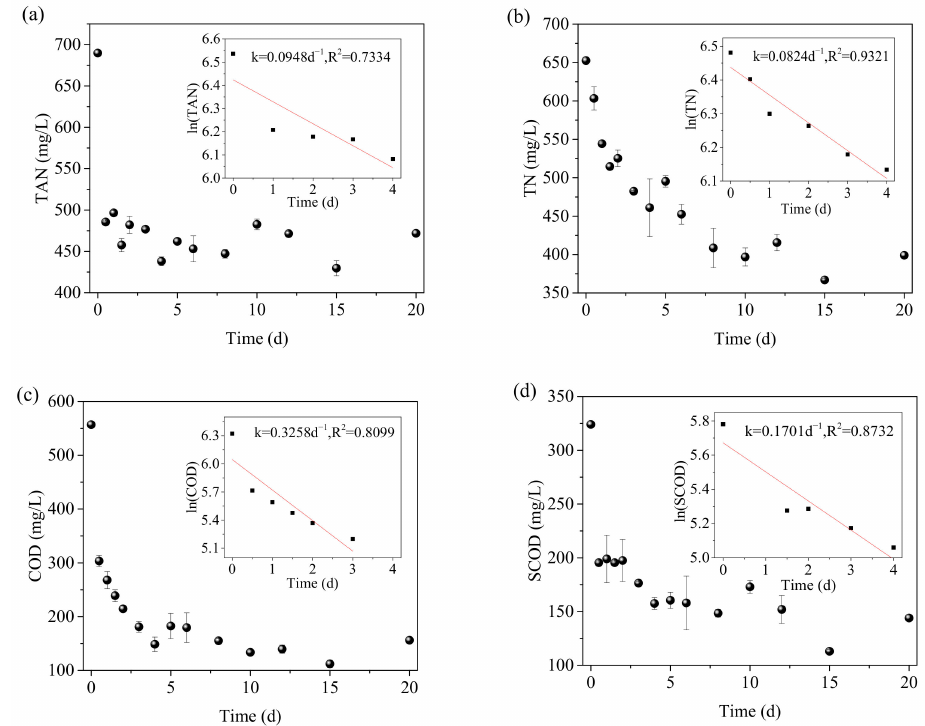
Figure 6. Soil biodegradation curve of reclaimed fertilizer. ( a ) TAN, ( b ) TN, ( c ) COD and ( d ) SCOD fitted by the first-order kinetic curve. Note: TAN—Total ammonia nitrogen; TN—Total nitrogen; COD—Chemical oxygen demand; SCOD—Soluble chemical oxygen